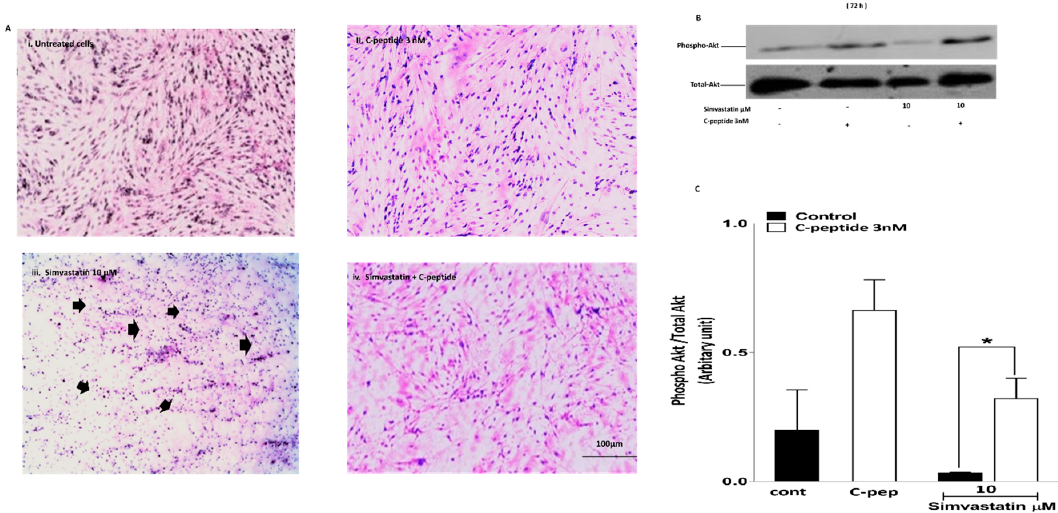
Figure 4. ( A ) C-peptide protects against simvastatin-induced cell toxicity. L6 myoblasts were serum starved in DMEM ( i ); treated with 3 nM C-peptide alone ( ii ); treated with simvastatin 10 µ M ( iii ); or treated with simvastatin in the presence of 3 nM rat C-peptide ( iv ) for 72 h. Morphological visualization was assessed by using the Wright stain and light microscopy. Black arrows indicate shrunken cells (consistent with apoptosis). Magnification × 200; ( B ) C-peptide blunts the inhibitory effect of simvastatin on phospho-Akt activation in L6 myoblasts. Cells were treated with 10 µ M simvastatin and co-incubated with 3 nM rat C-peptide for 72 h. Phosphorylation of Akt was determined by the Western blot using specific anti-phospho Akt antibody. As a loading control, membranes were reprobed with antibody against total Akt (shown in the lower blot); ( C ) densitometric analysis of four experiments. Data are presented as mean ± SEM * p <